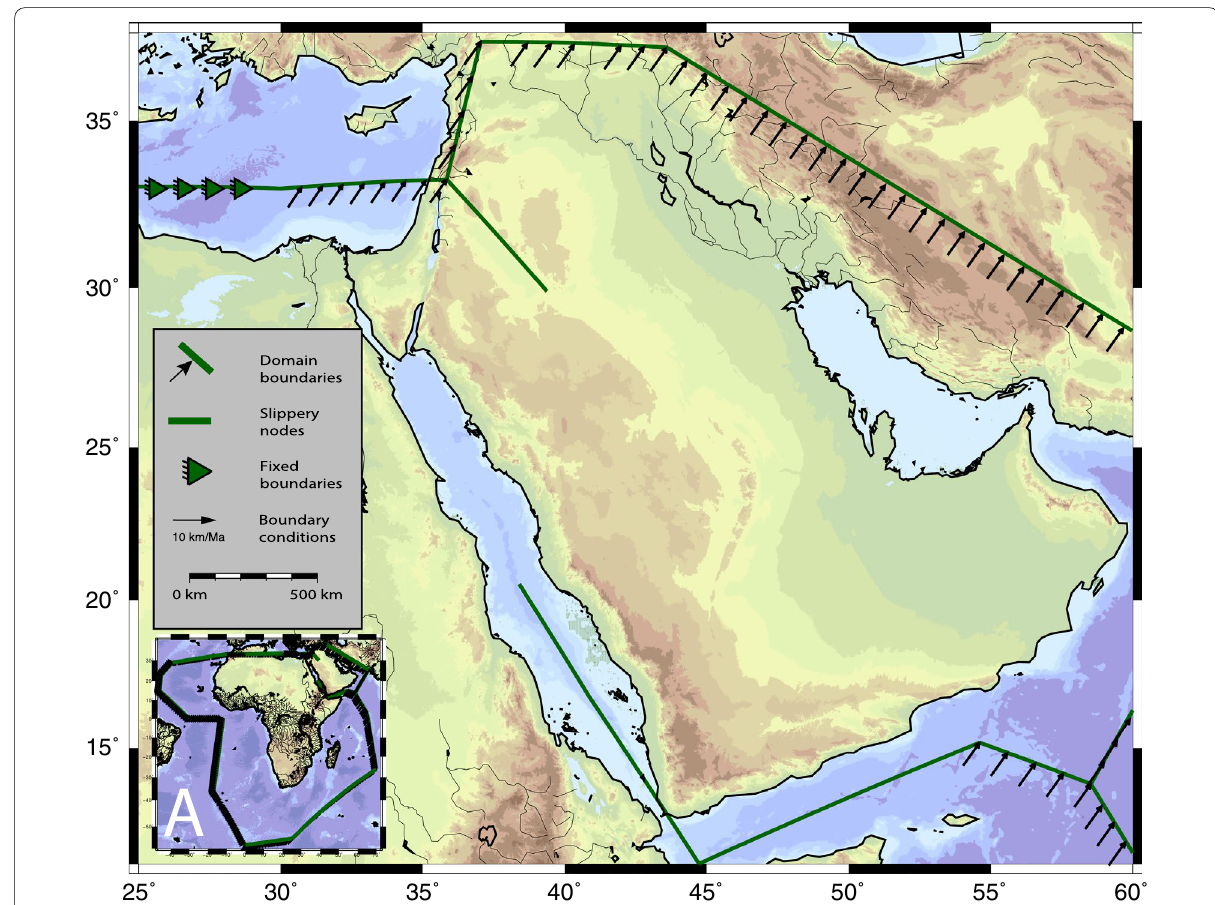
Fig. 3 Deformational model domain. This map shows the model domain for the Afro-Arabia plate system at 30–28 Ma. Because of this, the northern boundary of our domain does not coincide with the present geographic outlines for Nubia. The black arrows represent our boundary conditions with stable Eurasia reference frame. The green triangles denote our fixed boundaries. The green lines are assigned with slippery node conditions. The insert shows the whole model domain where we apply our boundary conditions and calculate the resulted strain rate